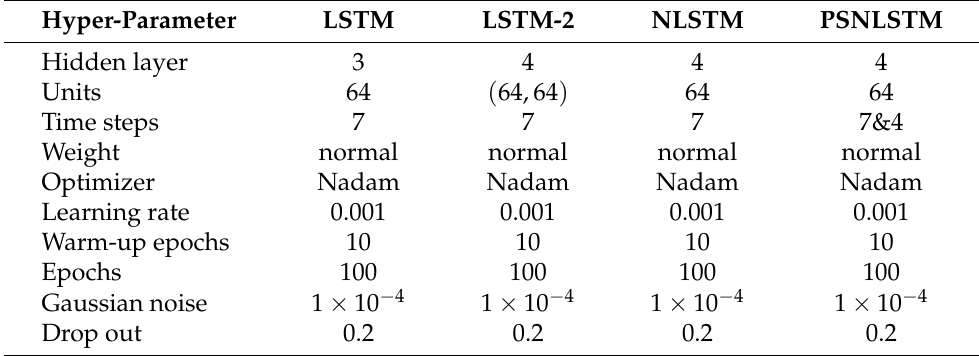
Table 2. The hyper-parameters of each network in the experiment.